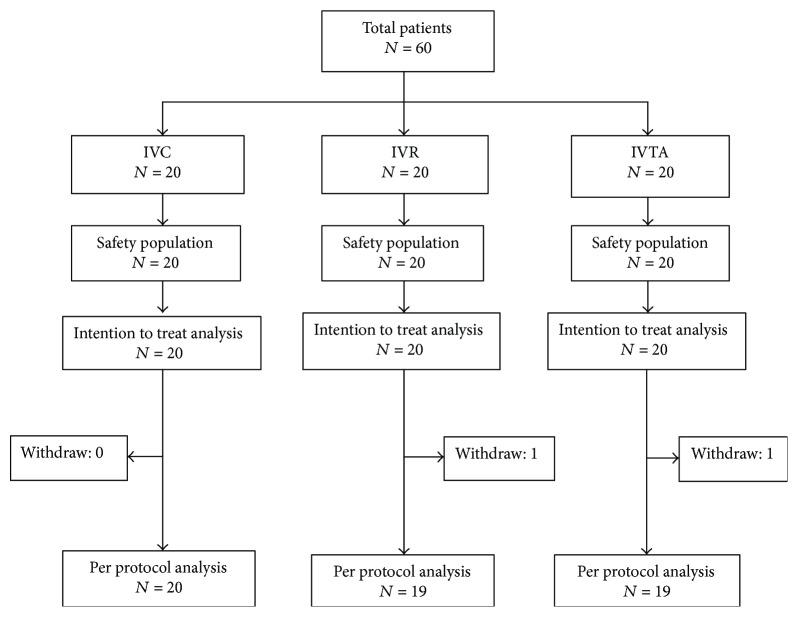
Study flow chart.